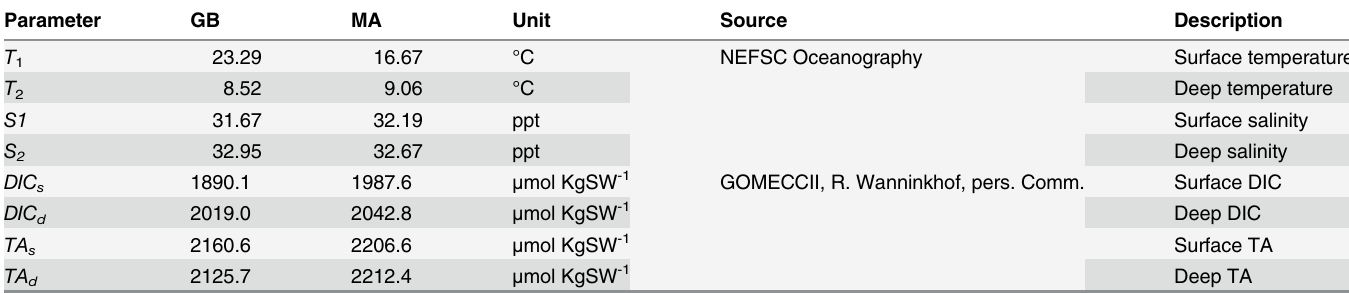
Table 4. Initial conditions for the biogeochemical